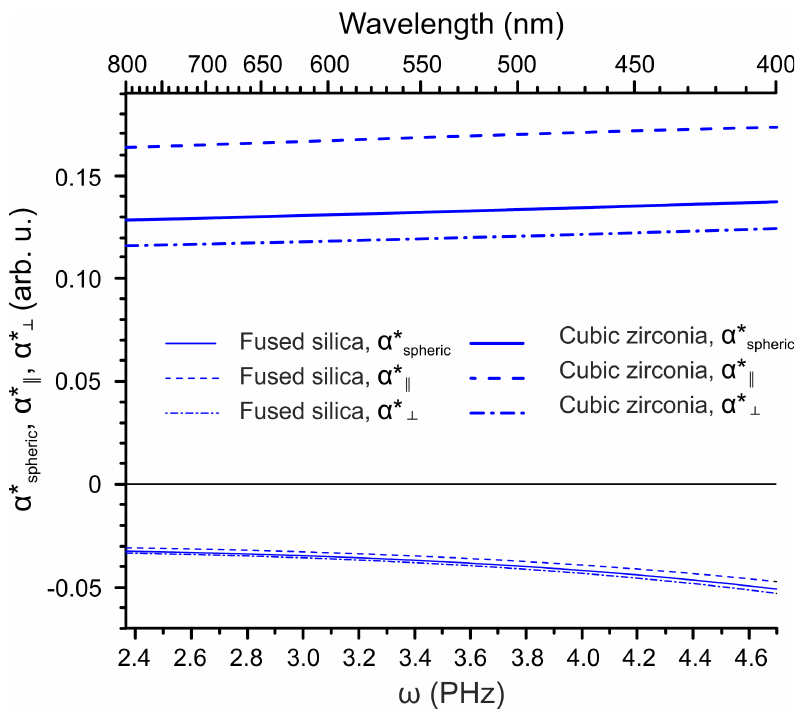
Figure 3. Frequency dependence of the effective polarizability of the fused silica and cubic zirconia NPs in the nematic host